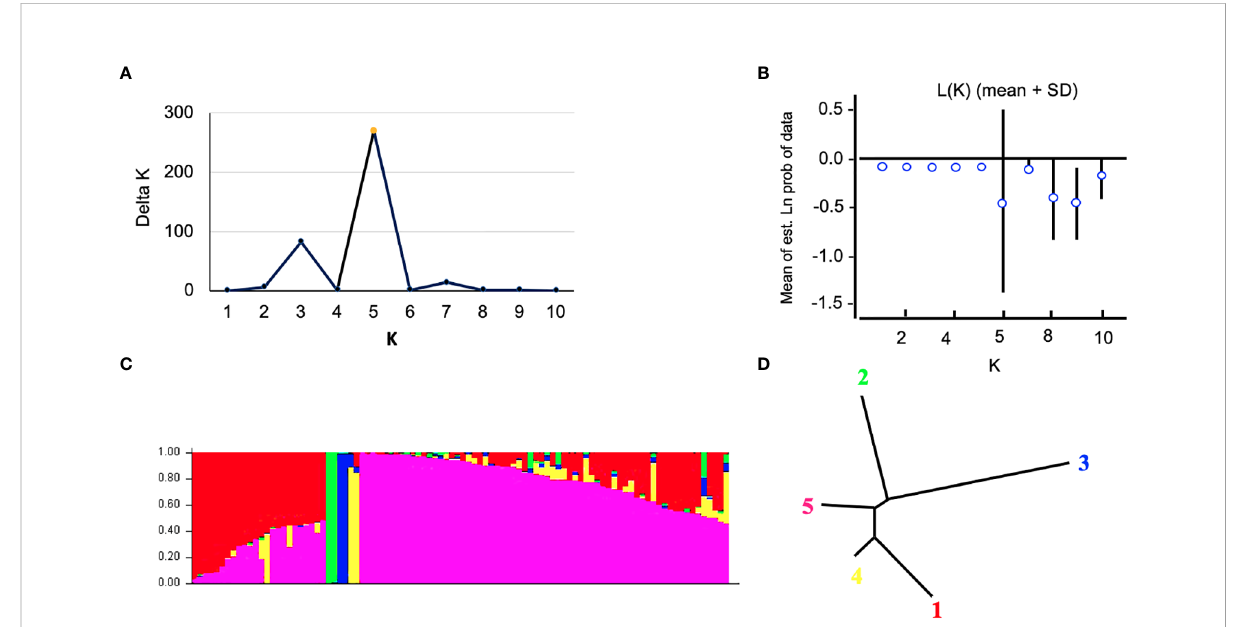
FIGURE 2 Analysis of population structure using 5063 SNP markers: (A) estimated population structure of 96 tow-rowed barley germplasm (k = 5). The y- axis the sub-population membership, and the x-axis is the genotypes, and (C) delta ( D ) K for different numbers of sub-populations, and (B) the average of the log-likelihood value. The mean values of ln P(D) and SD from 10 runs for each value of K 1/4 1 – 10. (D) Tree indicates the relationships among the fi ve subpopulations.